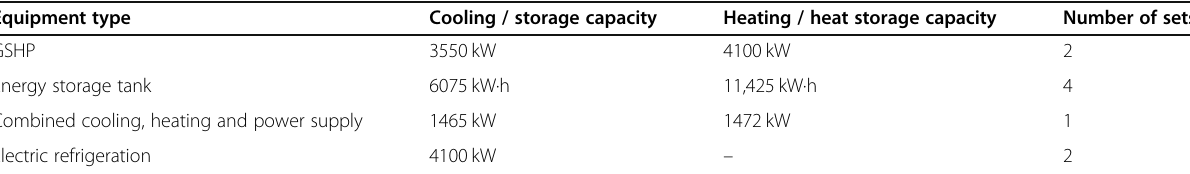
Table 2 Energy technology of the eco-city